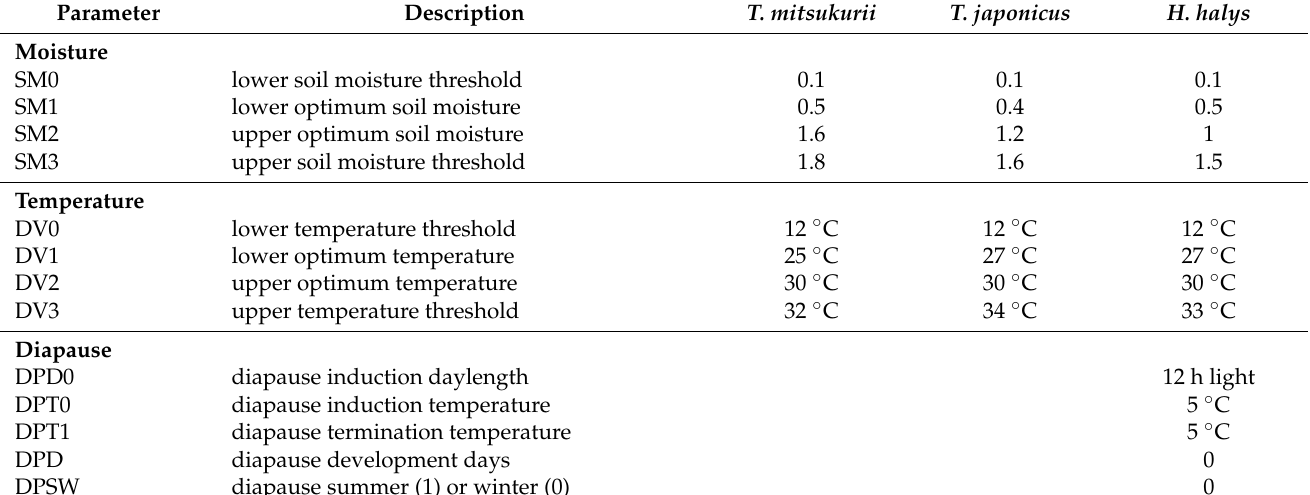
Table 1. CLIMEX parameter values for Trissolcus mitsukurii , Trissolcus japonicus [39] and Halyomorpha halys [7]. Parameter